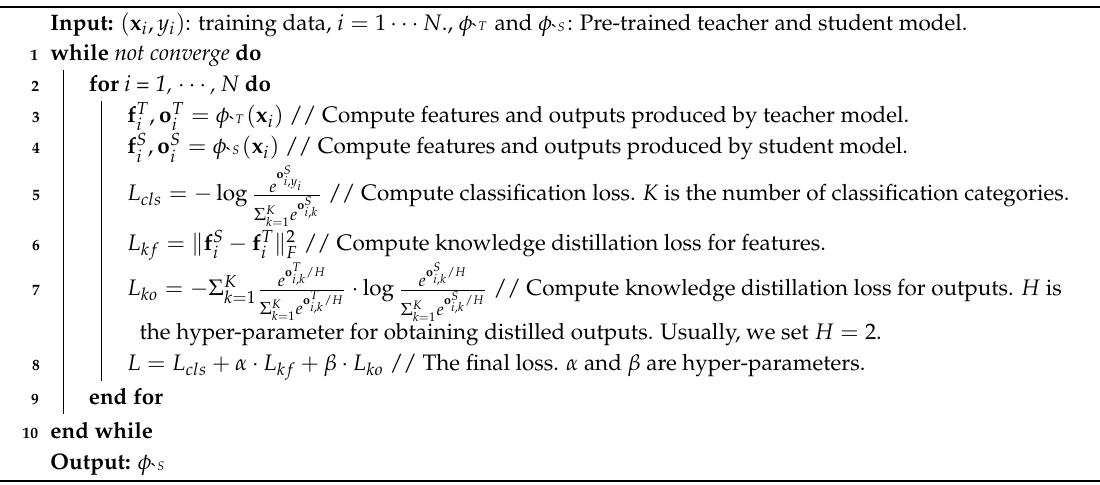
Algorithm 1: Knowledge Distillation for Satellite Image